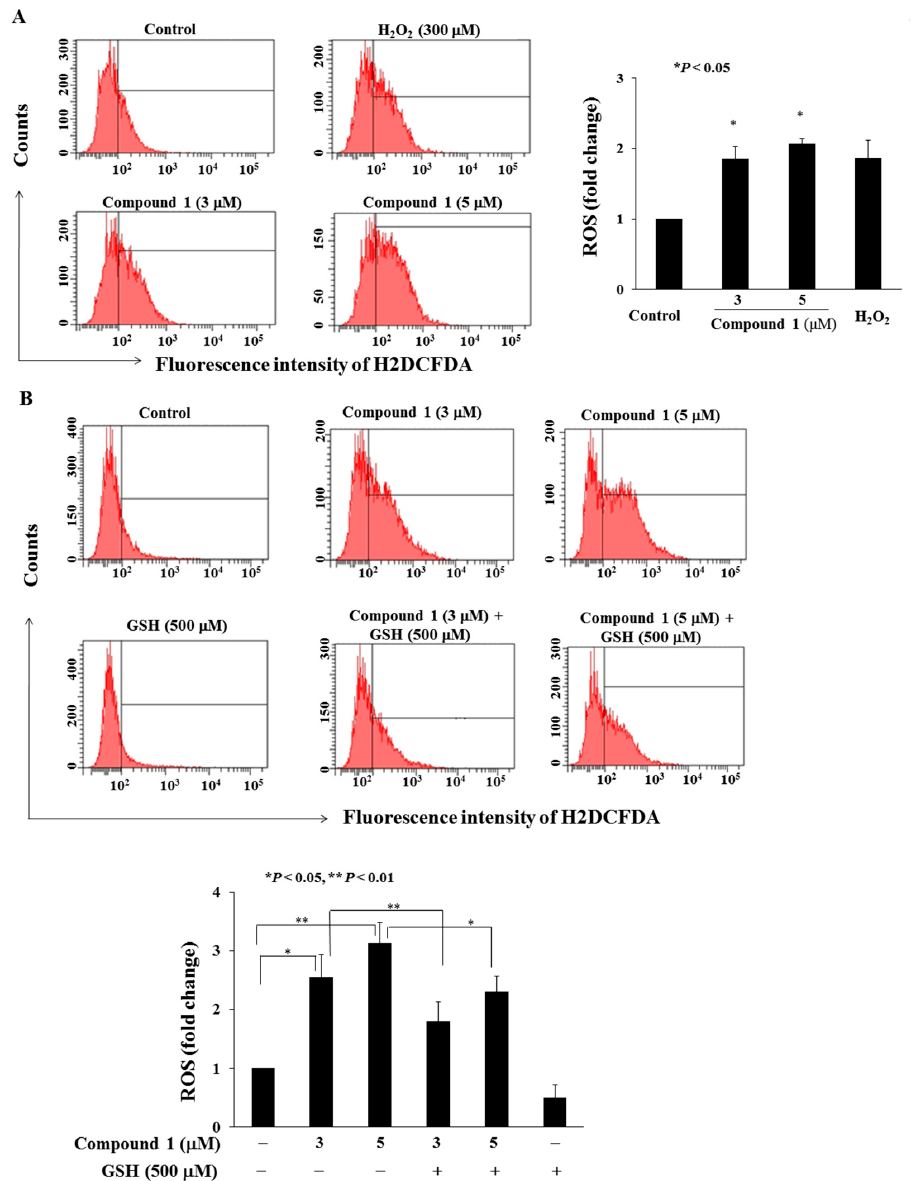
Figure 6. Compound 1 increased reactive oxygen species (ROS) generation. ( A ) Left panel, cells were treated with DMSO or compound 1 at the indicated concentration or 300 μ M H 2 O 2 for 3 h. Right panel, statistical analysis of ROS production in MCF-7 cells. ( n = 3). * p < 0.05 compared to control group; ( B ) Top, pre-treatment with 500 μ M glutathione (GSH) reversed compound 1 -induced ROS production; and bottom, statistical analysis of rescued effect of GSH on compound 1 -induced ROS production. Data are mean ± standard deviation (SD, n = 3).